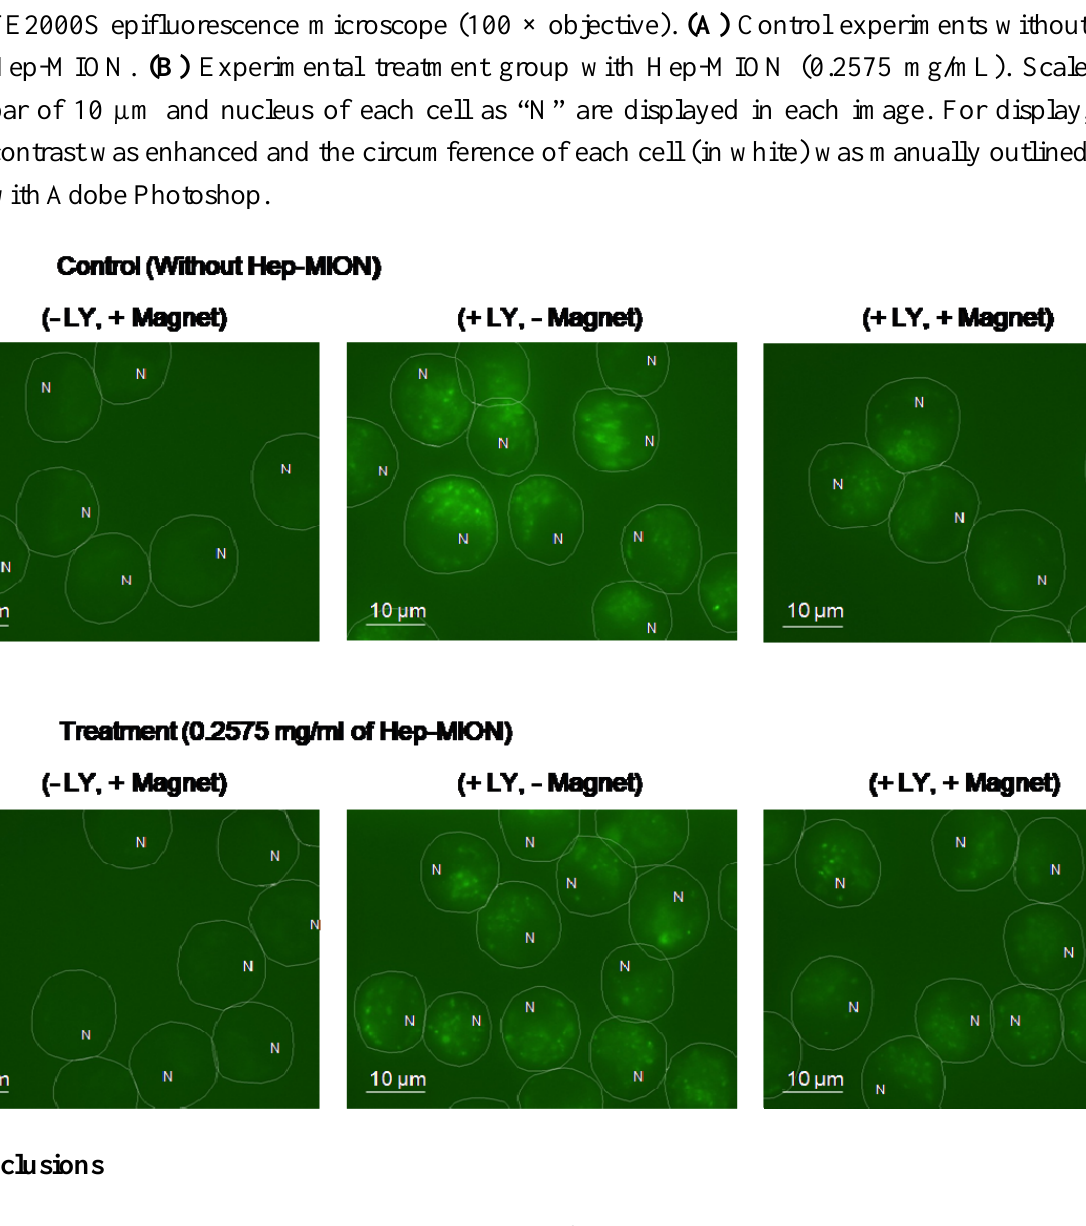
Figure 6. Lucifer Yellow (LY) uptake in the presence and absence of Hep-MION was investigated in transcellular transport experiments, with and without the magnetic